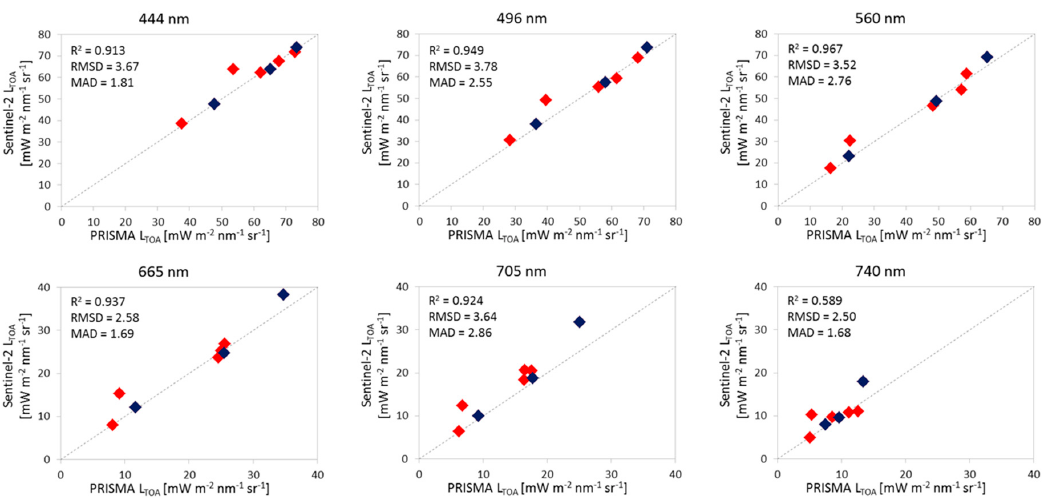
Figure 5. Scatterplots of TOA radiances from PRISMA (X-axis) vs. Sentinel-2 / MSI (Y-axis) for the eight match-ups (corresponding to five sites, i.e., all save Lucinda). Diamonds in blue highlight when PRISMA and Sentinel-2 / MSI were acquired on the same day, diamonds in red stand for ± 1 day mismatch.